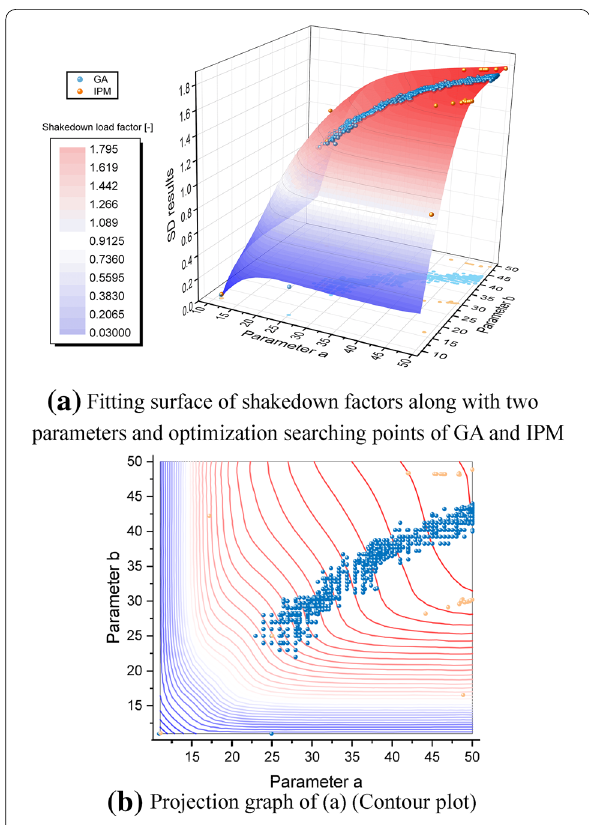
Figure 4 The fitting surface of shakedown factors and its